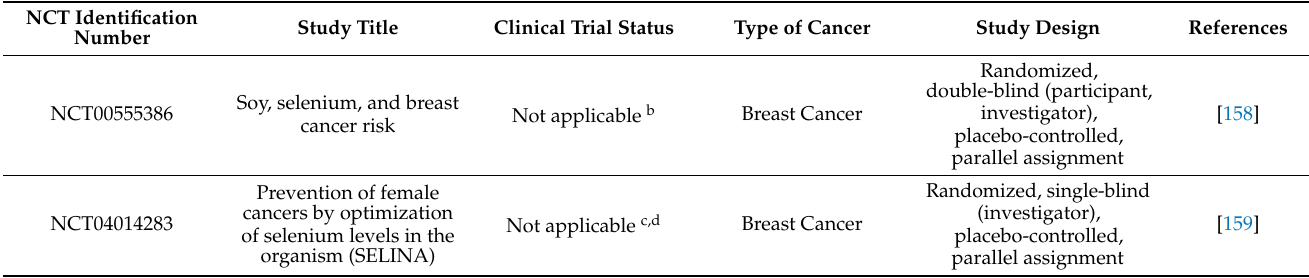
Table 3. Recent and current clinical trials on selenium chemoprevention in breast, colorectal, lung, and prostate cancer. This table was compiled from the information available at https://www.clinicaltrials.gov/ (accessed on 25 October